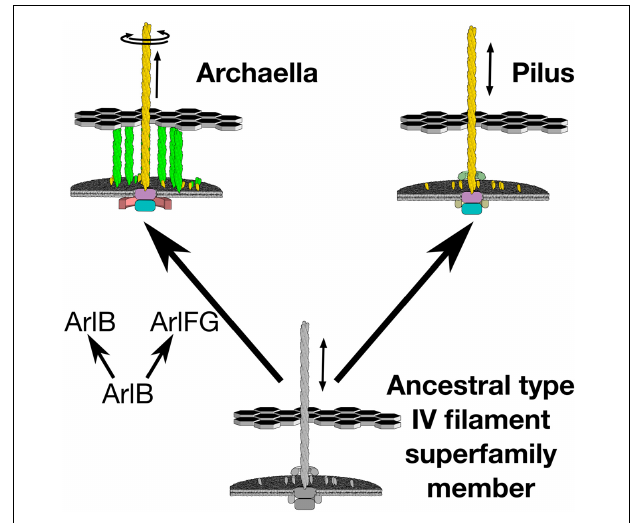
FIGURE 1 | Evolution of archaellar rotary propeller function coincided with duplication of a member of the ArlB family. The archaellum uses a single ATPase to both extend and rotate its archaellar filament. Emergence of this new function coincided with duplication of the archaellar filament protein, ArlB, to also provide ArlF and ArlG, putative stator complexes against which the archaellar motor can